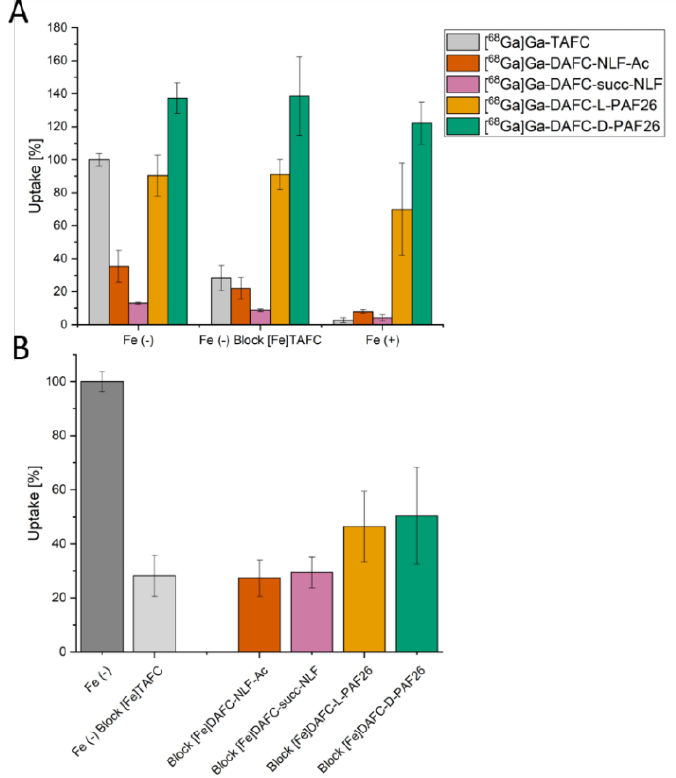
Figure 2. ( A ) Uptake of radiolabelled conjugates normalized to uptake of [ 68 Ga]Ga-TAFC of each experiment, respectively. Grey bars represent control with [ 68 Ga]Ga-TAFC. Uptake can be blocked with [Fe]TAFC due to competition for uptake by the MirB transporter. Iron-repleted conditions [Fe ( + )] lead to a decrease in MirB biosynthesis and active uptake into the hyphae. ( B ) Competition assay of [ 68 Ga]Ga-TAFC blocked with iron-containing antifungal conjugates in iron-depleted fungal culture. For all compounds a reduction of [ 68 Ga]Ga-TAFC uptake could be observed, indicating a specific interaction with the MirB